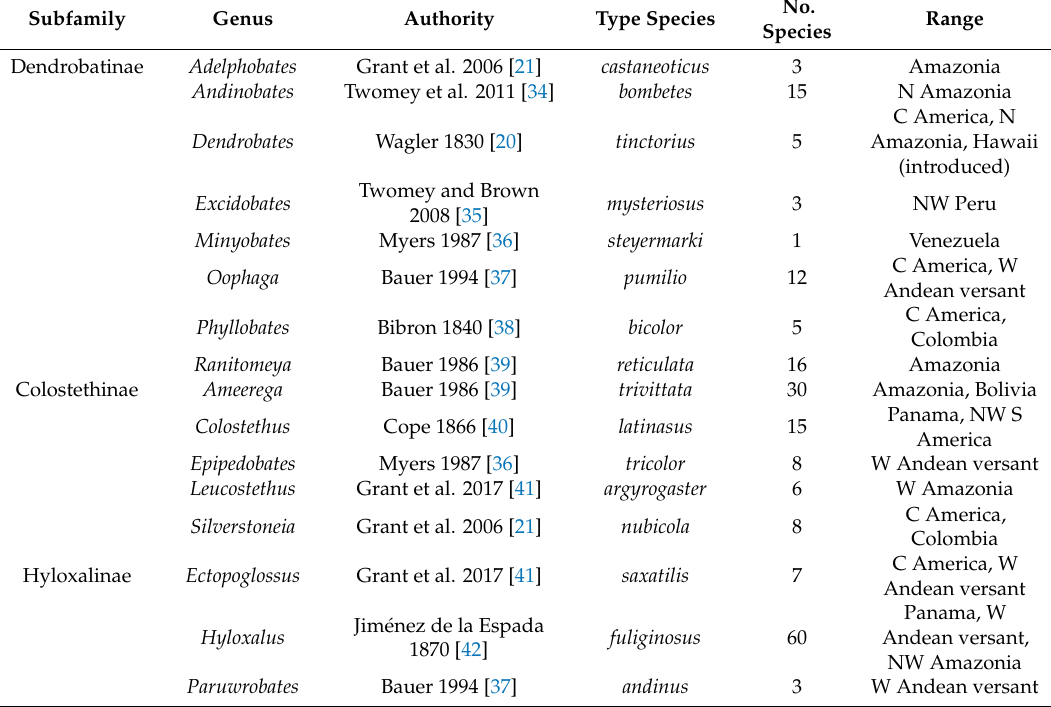
Table 1. Dendrobatid genera and relevant information. The authority and type species for each genus is given, as well as the number of described species and a very basic description of each genus’ geographic range. Species counts and authorities retrieved from Amphibian Species of the World